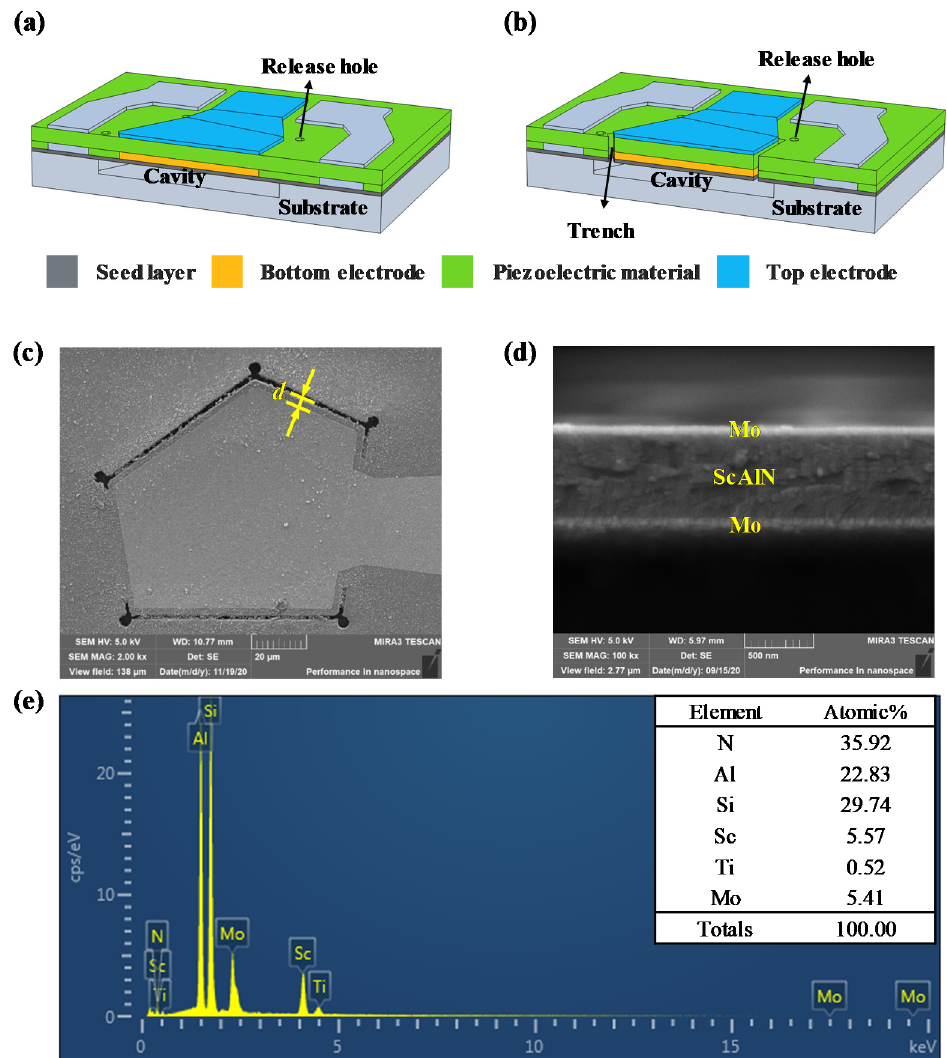
Figure 2. 3D cross-sectional schematics: ( a ) Traditional FBAR and ( b ) FBAR with trench. Scanning electron microscope (SEM) images for the fabricated FBAR: ( c ) Top view of FBAR with trench. ( d ) Cross-sectional view of FBAR with trench. ( e ) Energy-dispersive spectroscopy (EDS) elemental spectrum and quantification results.